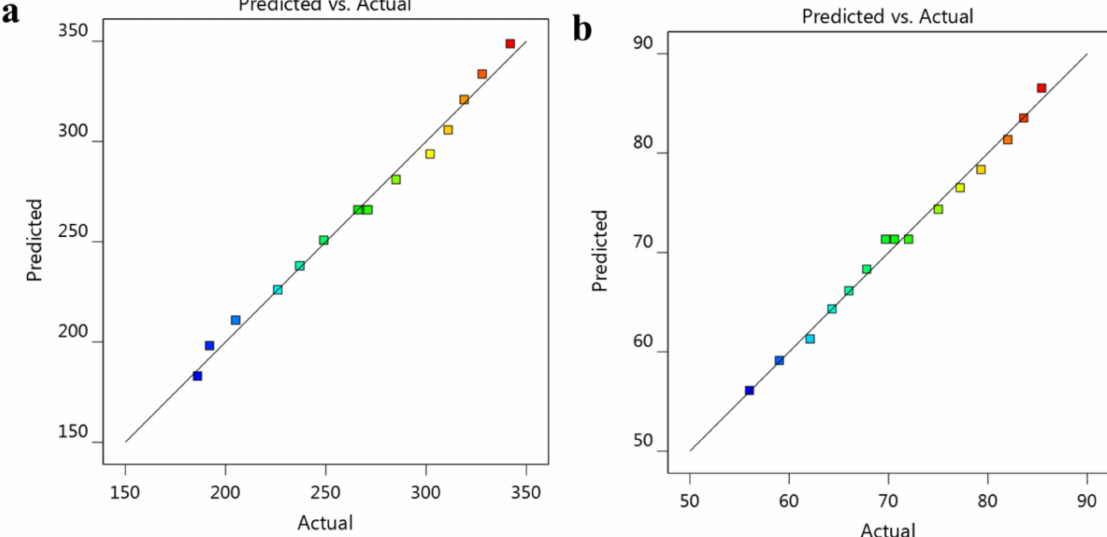
Figure 3. Linear correlation plot between predicted versus actual values for clarifying the influence of the lipid phase, surfactant and co-surfactant concentration on ( a ) particle size Y 1 and ( b ) EE Y 2